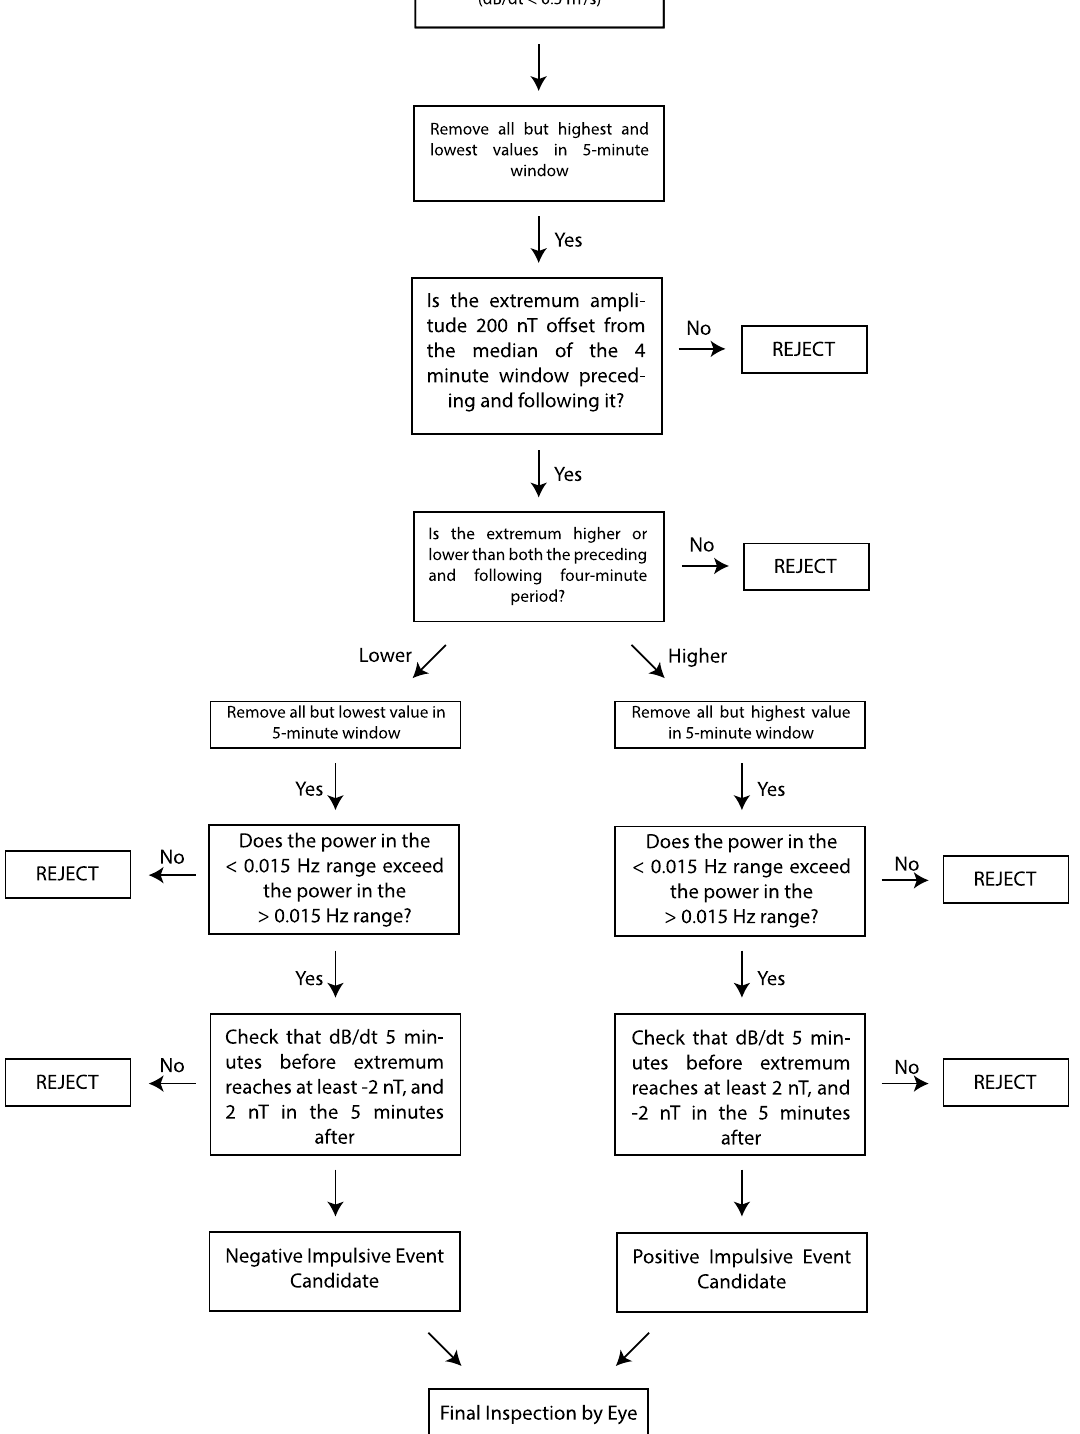
Fig. 2. A fl ow diagram depicting the selection criteria for impulsive events. Selection is conducted on a component-by-component basis for each individual